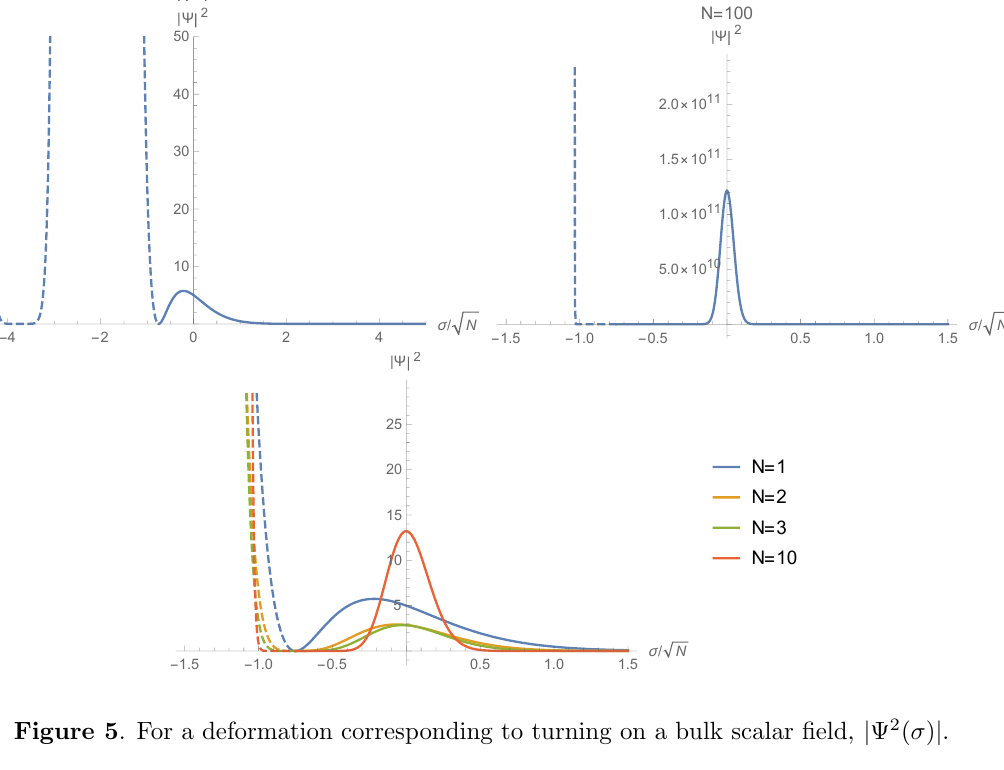
Figure 5 . For a deformation corresponding to turning on a bulk scalar (cid:12)eld, j (cid:9) 2 ( (cid:27) ) j .